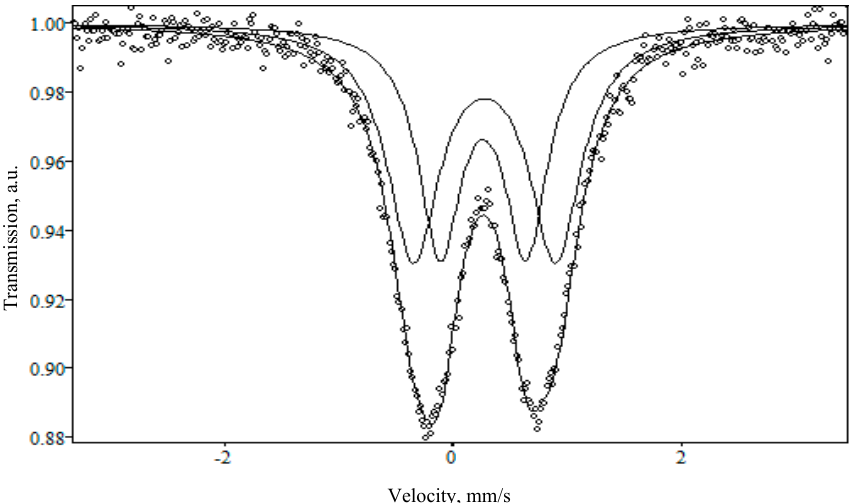
Figure 3. Mössbauer spectrum of the NaFeSi sample obtained at room temperature and in an external magnetic field.